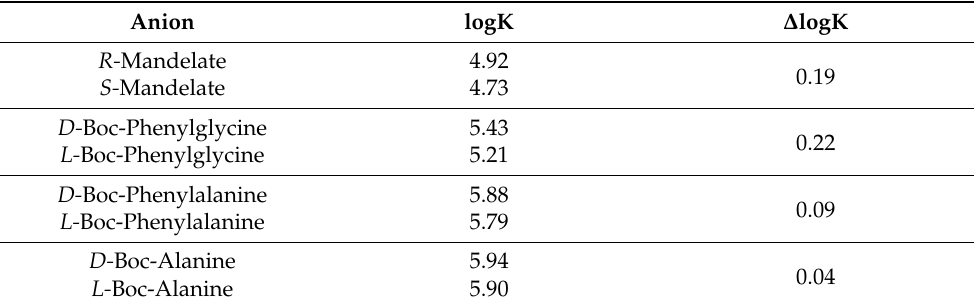
Table 3. Stability constants of complexes for receptor 58 in acetonitrile.